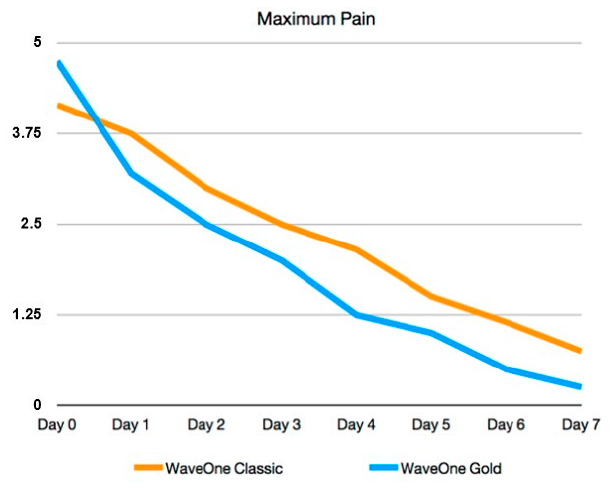
Figure 3. Maximum pain value ( p = 0.27).